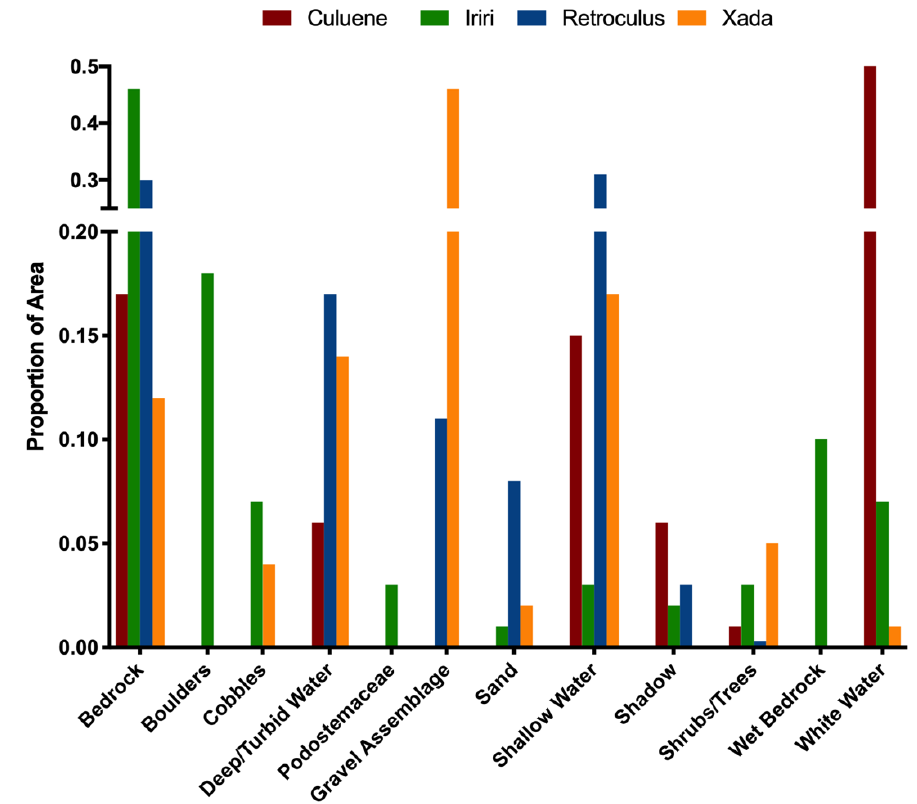
Figure 12. Proportion of substrate classes at Culuene, Iriri, Retroculus and Xadá as determined from the UAV SfM-MVS products and a neural network classification based on substrate exposed by the low water level of the dry season.